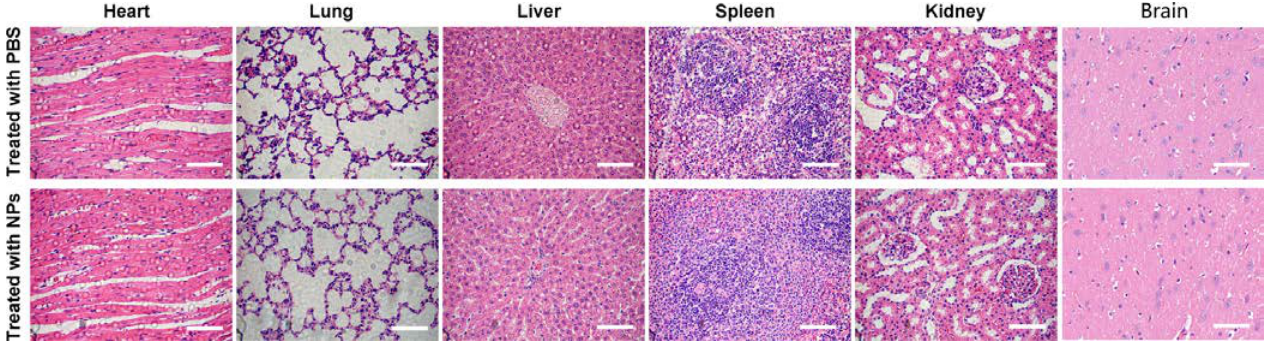
Fig. 5. Microscopic images of organ tissue sections from a rat in the control group (up) and a rat in the experiment group (down) for 30 days. Scale bar: 50 (cid:1) m.